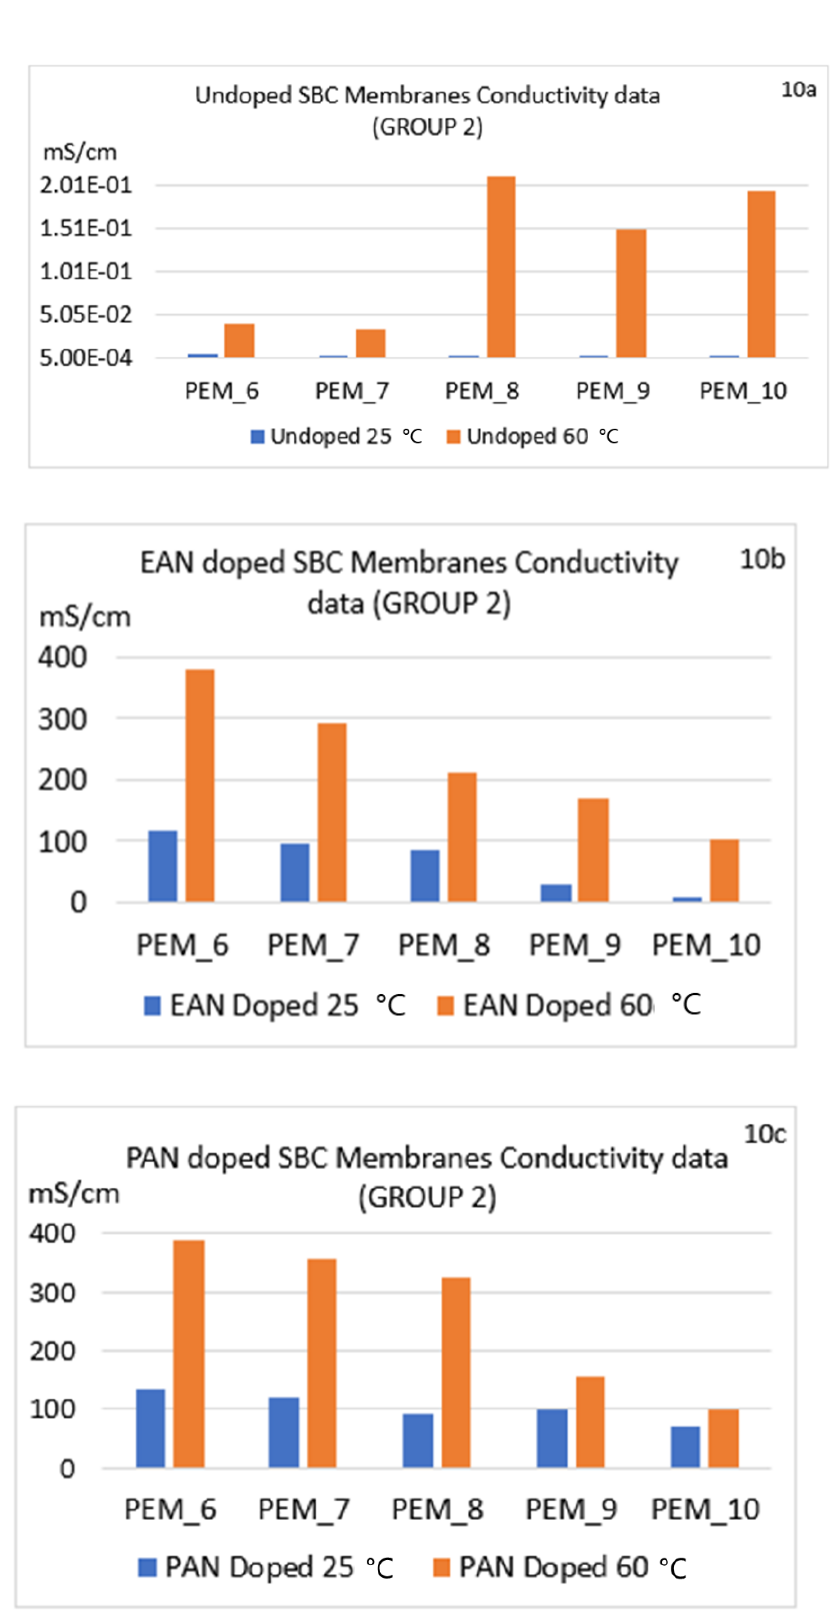
Figure 10. Comparison of conductivity values for nonannealed and annealed SBC membranes for all conditions for Group 2 membranes: PEM_6–PEM_10 (undoped and doped). ( a ) Undoped ( b ) EAN doped ( c ) PAN doped